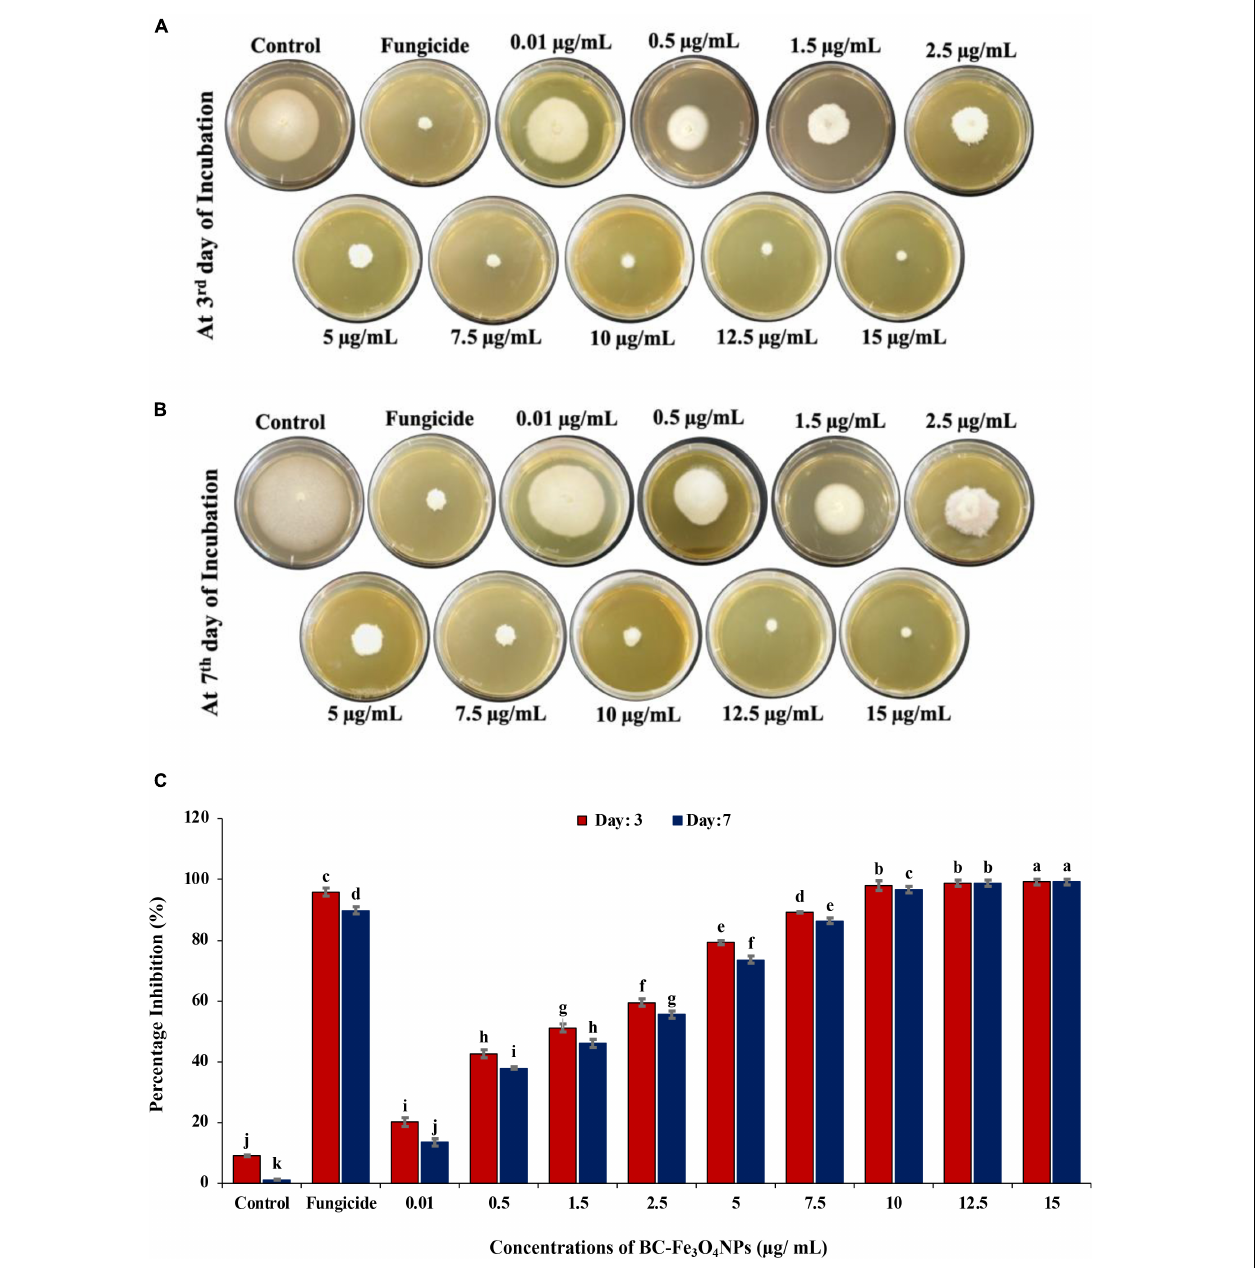
FIGURE 11 | Comparing the effect of BC-Fe 3 O 4 NPs on mycelial radial growth of F. oxysporum at various concentrations (0.01–15 µ g/ml) in parallel to control and fungicide treatment after 3 and 7 days of incubation at 28 ◦ C. (A,B) Plates indicating antifungal activity of BC-Fe 3 O 4 NPs in PDA plates at third and seventh day. (C) Showing percentage inhibition graph of BC-Fe 3 O 4 NPs on mycelial growth of F. oxysporum . Vertical bars represent SD ( n = 3) between the mean of different replicates of the same treatment. Different letters per column indicate significant differences among treatments, determined by the ANOVA and LSD tests at P ≤